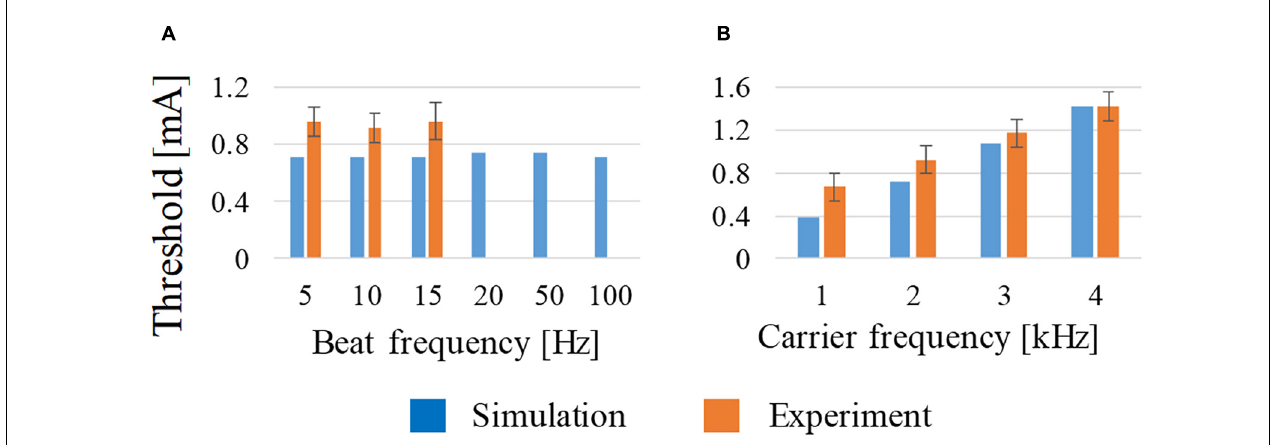
FIGURE 3 | Effect on the activation threshold of (A) beat frequency at constant carrier frequency (2 kHz) and (B) carrier frequency at constant beat frequency (10 Hz) using amplitude ratio of I 1 and I 2 of 7:3. For comparison, experimental observations of behavioral stimulation are also shown.